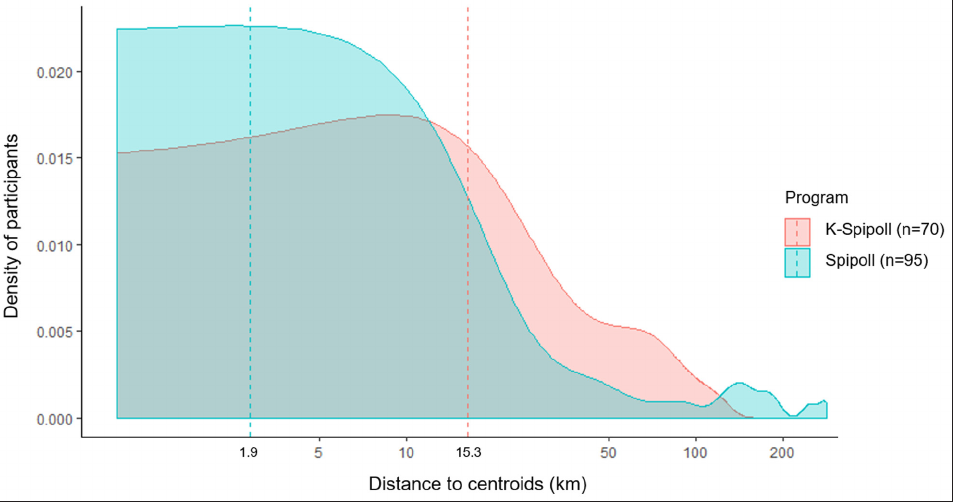
Figure 3: Distance to centroids per observers for each program. In each panel, dotted lines represent the median value for Spipoll and K-Spipoll (in blue and red